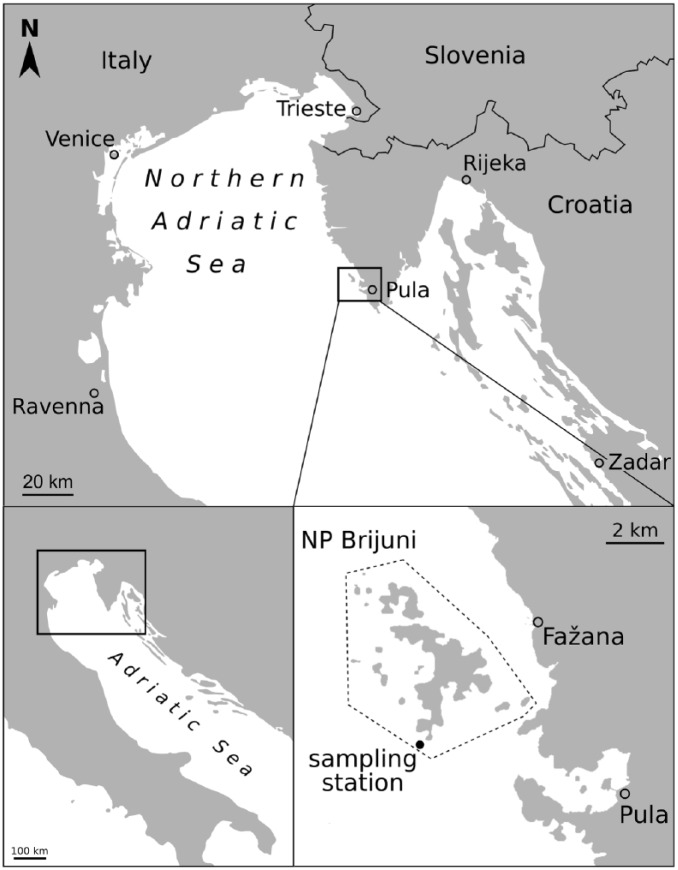
Map of the Brijuni Islands, Croatia, and exact location of the sampling station within the marine protected area of the national park Brijuni (NP Brijuni). The grey dotted line marks the boundaries of the national park.